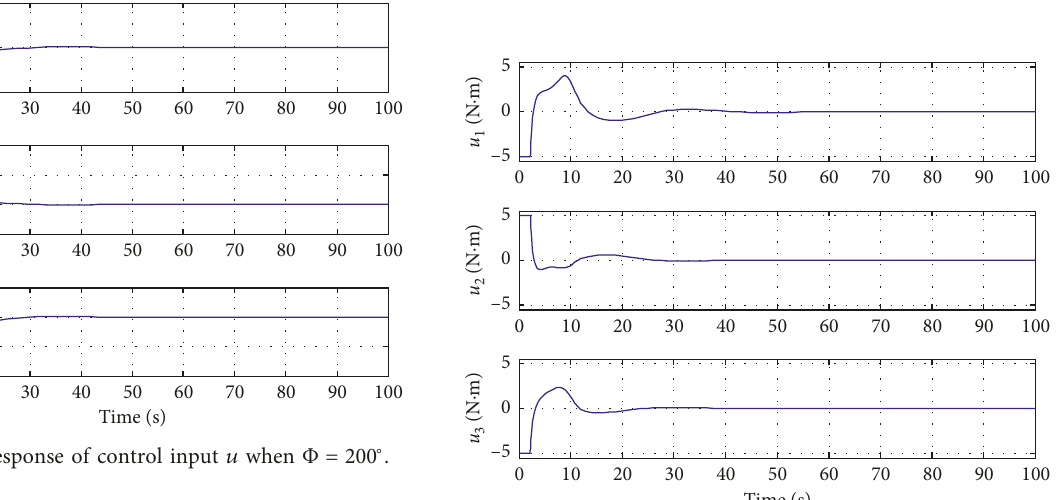
Figure 5: Time response of angular velocity w when Φ � 320 ∘ after saturation.